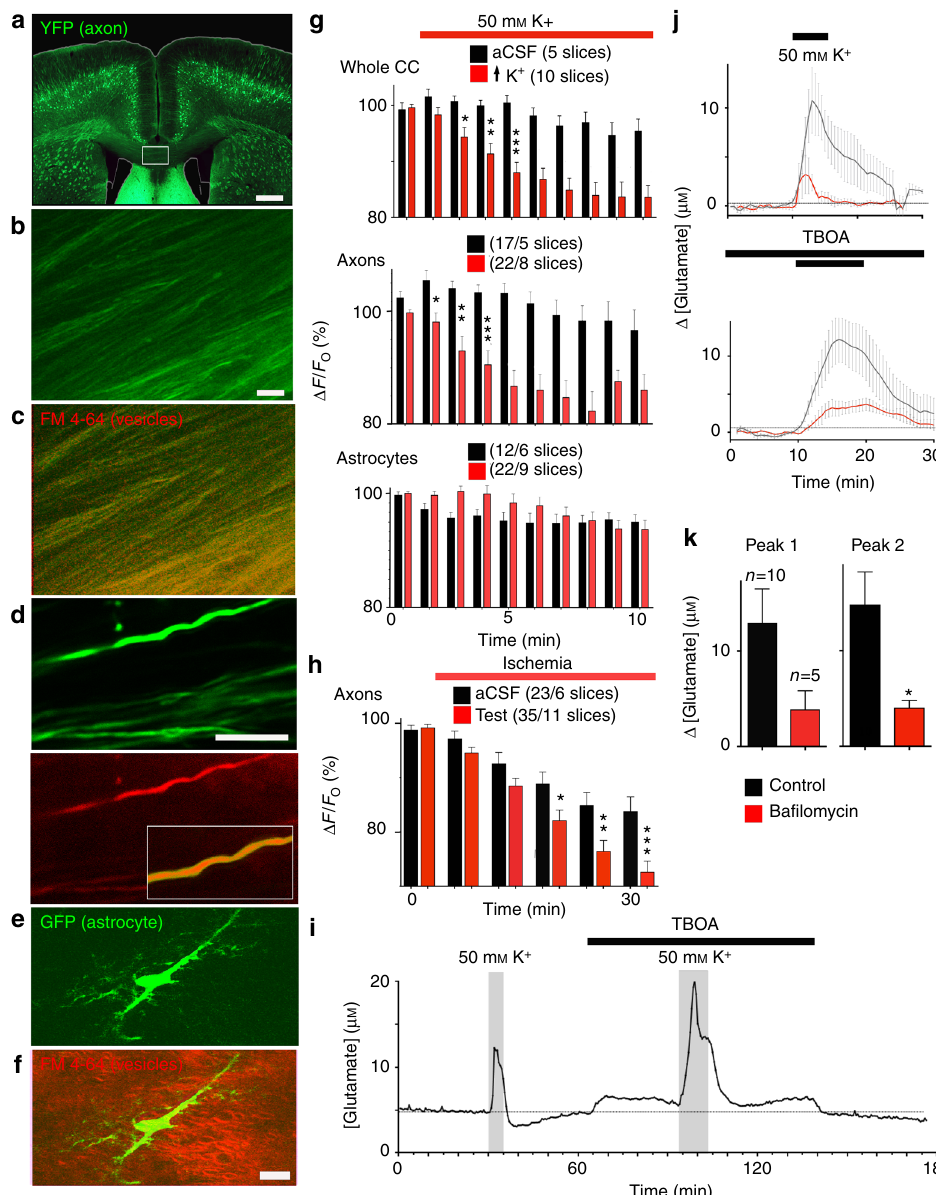
Fig. 1 Axons are the principle site of white matter vesicular fusion. a Thy-1-YFP expression in adult coronal section (box: corpus callosum). b , c YFP( + ) corpus callosum axons ( b ) and FM4-64 vesicles ( c overlaid red). d Single axons (overlaid at higher gain in the box). e , f Corpus callosum astrocyte ( e ) in adult GFAP-GFP mouse and FM4-64 staining ( f overlaid red). g K + -evoked FM4-64 de-staining in whole corpus callosum, axons, and astrocytes. h Corpus callosum axon FM4-64 de-staining in aCSF and during ischemia. i K + -evoked [glutamate] e release is not inhibited by TBOA. j Both the fi rst (top) and second (bottom) 50 mMK + -evoked glutamate rise is reduced by ba fi lomycin (50 nM, red trace). k Data summary shown on the bottom. Scale = 1 mm ( a ), 10 μ m ( b , d , f ). Stars indicate the fi rst mean to reach signi fi cance. Grouped analysis ANOVA; correct for multiple comparisons using the Holm − Š ídák method. P values: g top *0.016, **0.001, ***0.0000; g middle *0.038, **0.002, ***0.0004; h *0.021, **0.009, ***0.0013. Unpaired t- test P values: k Peak 1 ns 0.1119; Peak 2 (Fig. 3c, d). Glutamate release was nodal space that is contiguous with the periaxonal space takes + -dependent and was signi fi cantly reduced by blockers of Ca 2 vesicular glutamate release (50 nM ba fi lomycin or 500 nM rose bengal; Fig. 3e, f), con fi rming the signi fi cance of vesicular release to ischemic [glutamate] e elevation in white matter. RON axon. Prior studies have shown that short periods of NMDA receptors mediate acute myelin injury during ischemia . ischemic injury 11,22 , and we also found no protection following a Drug penetration into the peri-axonal space is known to be slow. 20 min pre-treatment period with MK-801 (Fig. 4b). However, For example, diffusion from the node of Ranvier into the peri-